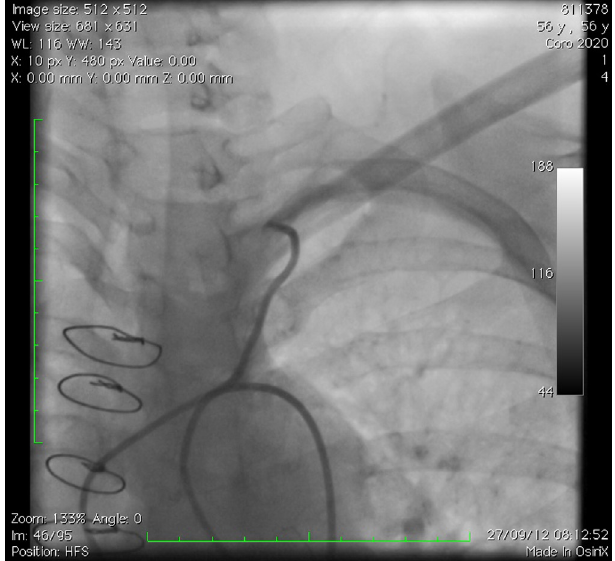
Fig. 1 - Filling of the left subclavian artery by retrograde flow of the left internal mammary